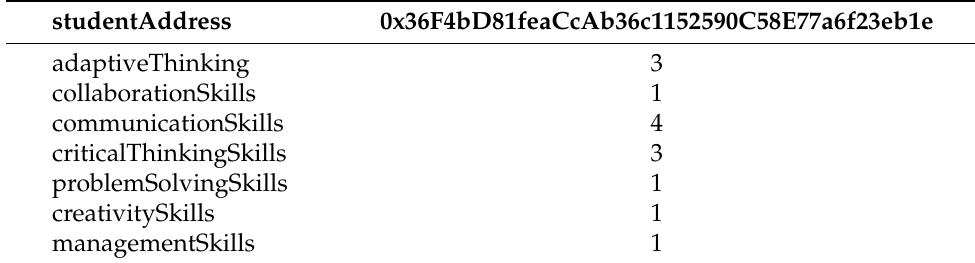
Table 1. Skills development for the certain student.